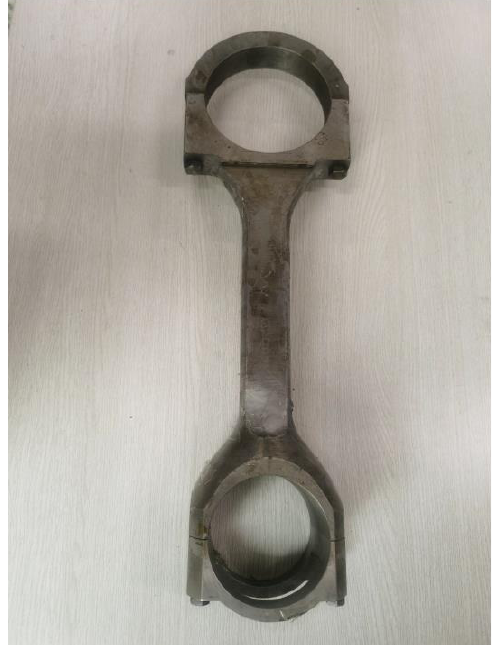
Figure 25. 1/4 scale model.